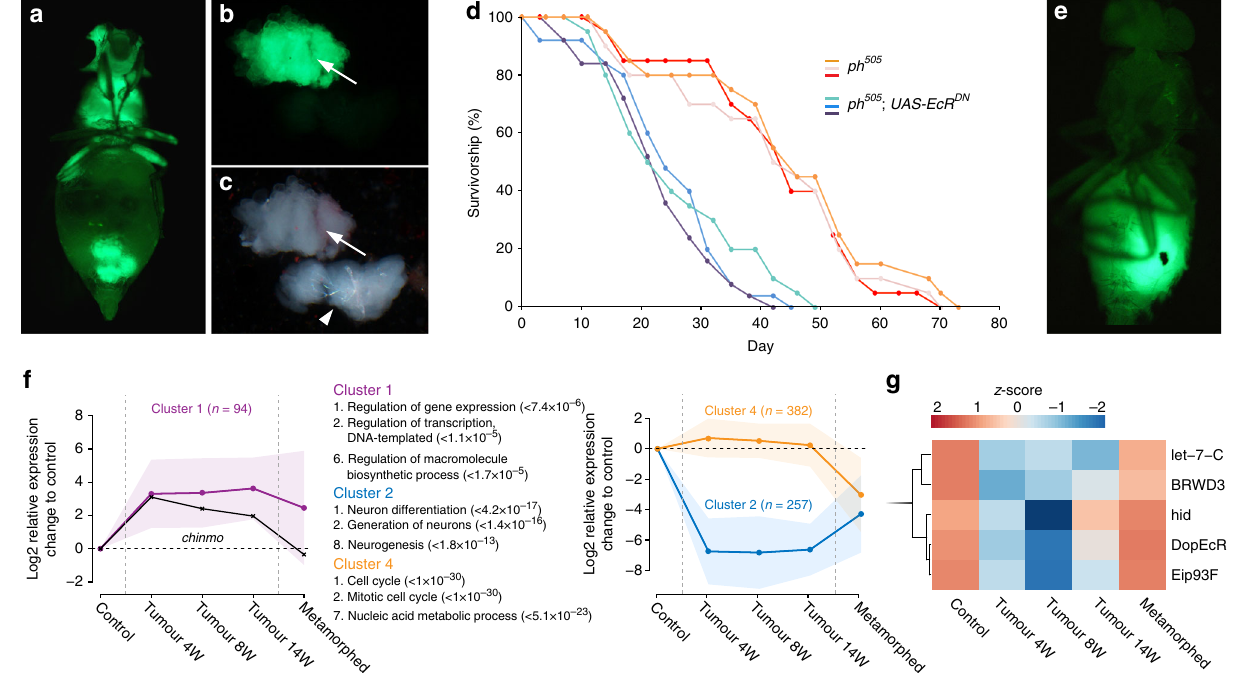
Fig. 2 Ecdysone controls the conversion into metamorphed ph 505 cells. a An adult fl y of ph 505 ; UAS-EcR DN 3 weeks after eclosion, showing the formation of large tumours throughout the body. b , c Dissected tumour mass (arrow) from the head of an adult fl y as in a ; note the size of the tumour is similar to that of the adult brain (arrowhead in c ). d Survival of ph 505 and ph 505 ; UAS-EcR DN adult fl ies, showing a strongly reduced lifespan of ph 505 ; UAS-EcR DN adults. For each genotype, three independent experiments were carried out and indicated by different colours (see Methods for details). e Formation of tumours in a wild-type host after transplantation of ph 505 ; UAS-EcR DN cells dissected from the head. f Clustering of signi fi cantly differentially expressed genes and their associated GO-terms. Cluster 1 consists of transcription regulators that are upregulated in tumours, some of which return to pretumour levels in metamorphed ph 505 cells. Cluster 2 describes genes required for neuron differentiation which are downregulated in both tumours and metamorphed ph 505 cells, but cluster 4 consists of genes involved in cell cycle that are only downregulated in the metamorphed ph 505 cells. All n genes of the respective cluster can be found within the shaded area, whereas the lines denote the mean. The complete clustering analysis result is shown in Supplementary Figure 3. g Heat map of fi ve ecdysone responsive genes whose expression was decreased in tumours, but upregulated in the metamorphed ph 505 cells. The complete heat map of the expression of all genes known to respond to ecdysone is shown in Supplementary Fig. 4. Genotypes: a , b , c ph 505